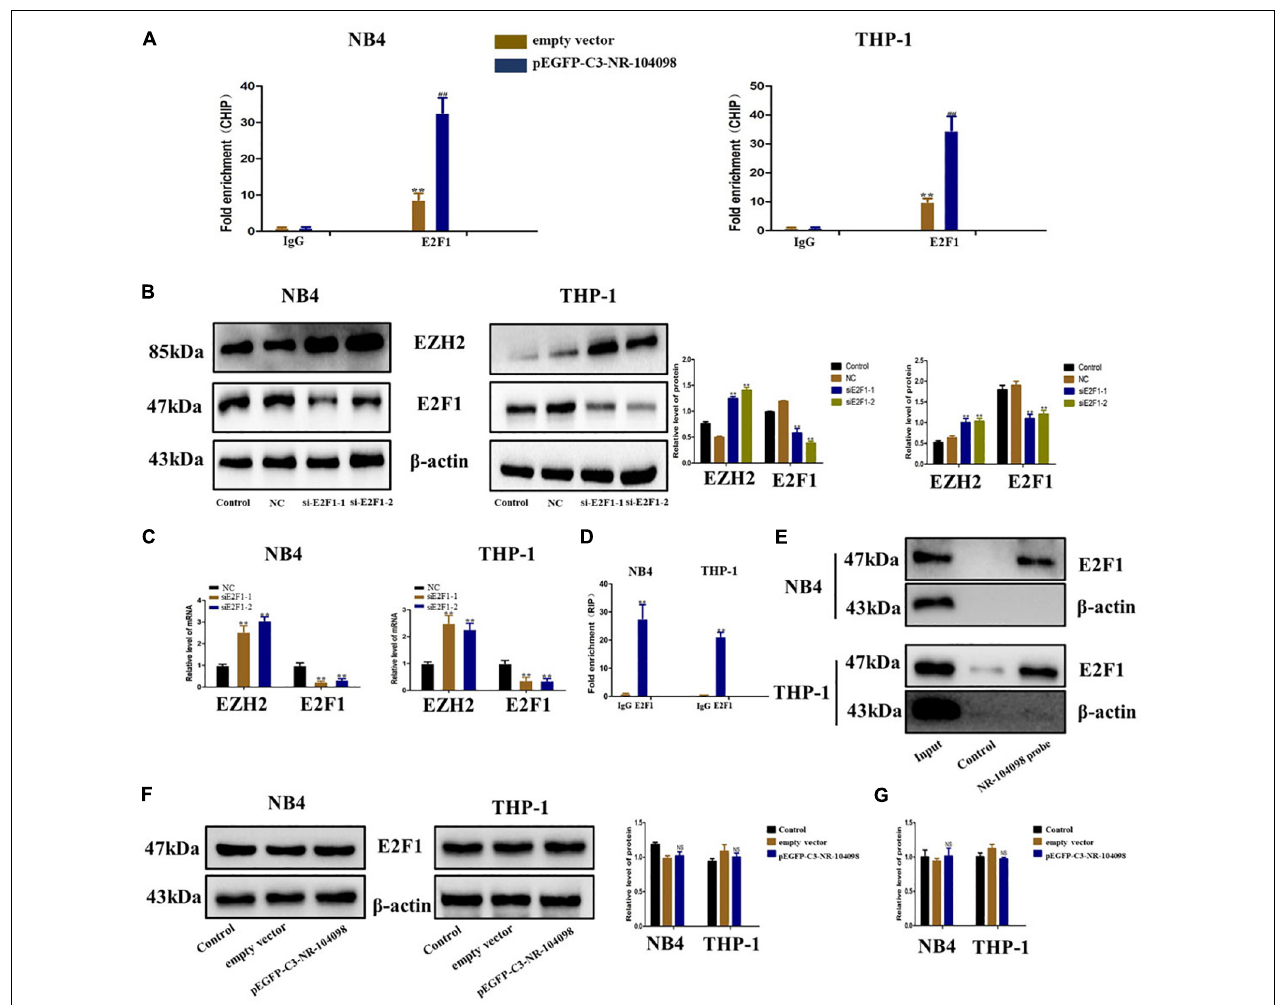
FIGURE 8 | lncRNA NR-104098 downregulated transcriptional expression of EZH2 through recruitment of E2F1 in AML cells. (A) pEGFP-C3-NR-104098 or the empty vector was transfected into AML cells, and chrome immunoprecipitations were performed by using specific anti-E2F1 antibodies. (B) AML cells transfected with E2F1 siRNAs or the control siRNA for 72 h were collected, and EZH2 and E2F1 protein levels were detected by Western-blot assay. (C) E2F1 siRNAs (E2F1-1, 2) or the control siRNA were transfected into AML cells for 48 h, E2F1 and EZH2 mRNA levels were then assessed by RT-qPCR. (D) RNA immunoprecipitations were performed in AML cells, and the relative quantities of lncRNA NR-104098 were detected by RT-qPCR assay, normalized to the input groups. IgG and E2F1 represented for the groups coprecipitation with IgG protein and anti- E2F1 antibody respectively. (E) Total proteins were extracted from NB4 and THP-1 cells, and then lncRNA NR-104098 pull-down assay was performed. The E2F1 protein levels were evaluated by Western-blot. LncRNA NR-104098 probe represented the biotin-labeled lncRNA NR-104098 probe group and control stood for the oligo probe group. NB4 and THP-1 cells with pEGFP-C3-NR-104098 or the empty vector was harvested, and expression levels of E2F1 protein (F) and E2F1 mRNA (G) were detected. β -Actin served as a loading control. Data are presented as the mean ± SD of three independent experiments. ∗ p < 0.05, ∗∗ p < 0.01, compared with the NC group. NS no significant difference between the groups, # p < 0.05, ## p < 0.01, significant difference between pEGFP-C3-NR-104098 and the empty